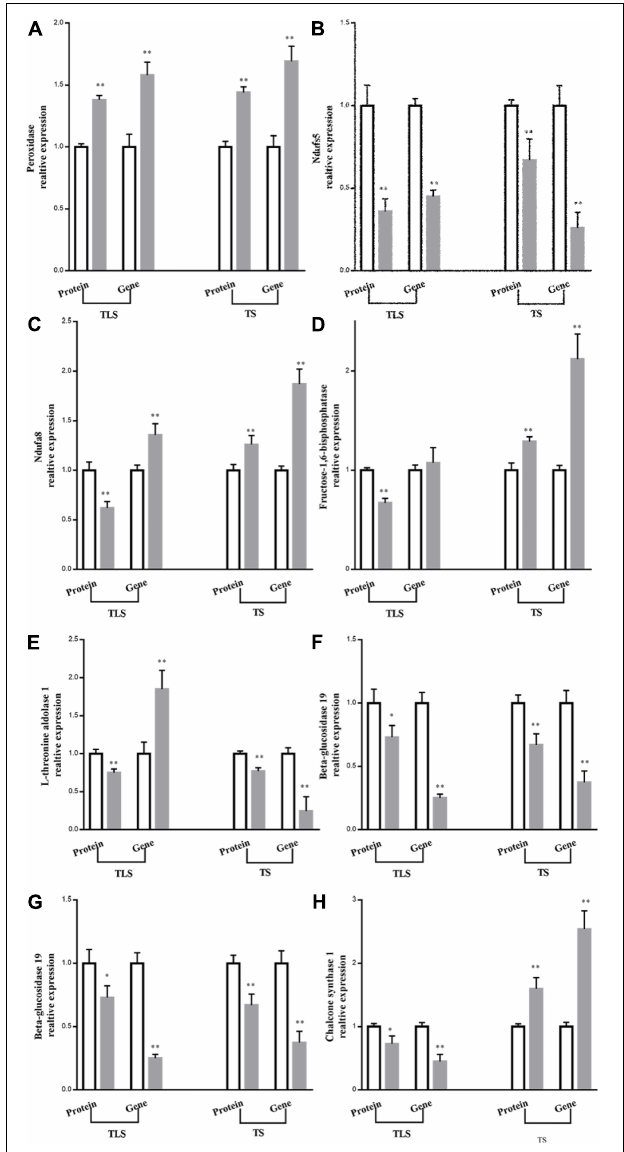
FIGURE 10 | Comparison between protein abundance and mRNA level. The protein abundance in ground treatment and after spaceflight treatment leaves at three-leaf stage (TLS) and tillering stage (TS) were assessed by ITRAQ based quantitative proteome analysis. Transcript abundance at two development stages (TLS, TS) was determined by quantitative RT-PCR and normalized against the ACTIN gene. The white column represents the control group; gray column represents treatment group. The means and standard error values from three independent samples are shown (means ± SE; n = 3). * and ** indicate significant difference at p < 0.05 and < 0.01 by student t -test, respectively.